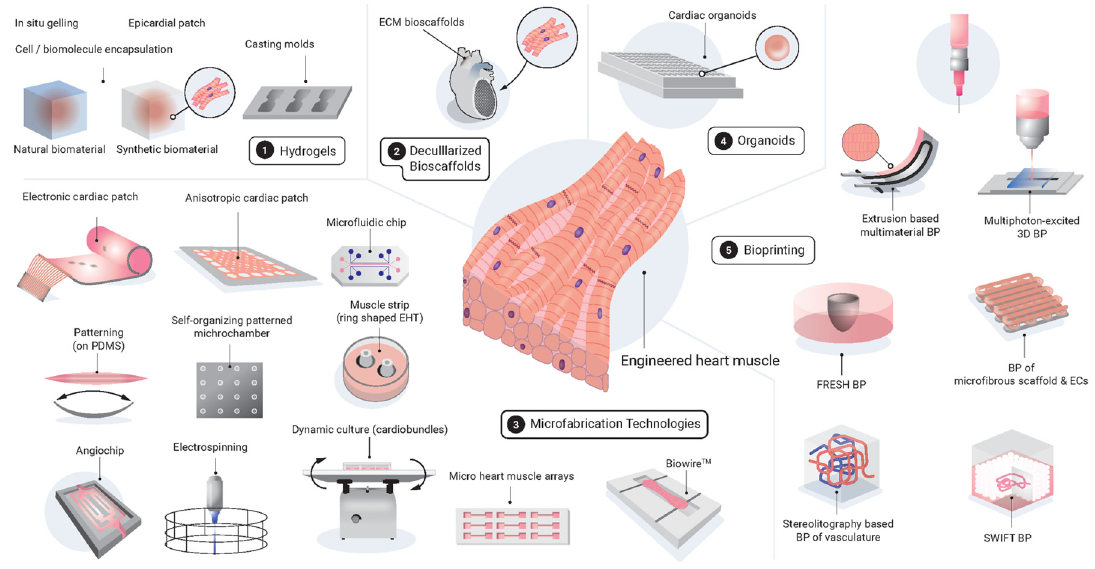
Figure 1. Schema of the latest biomaterials and biofabrication technologies for the generation of engineered heart muscles. 3D, three-dimensional; BP, bioprinting; EC, endothelial cell;